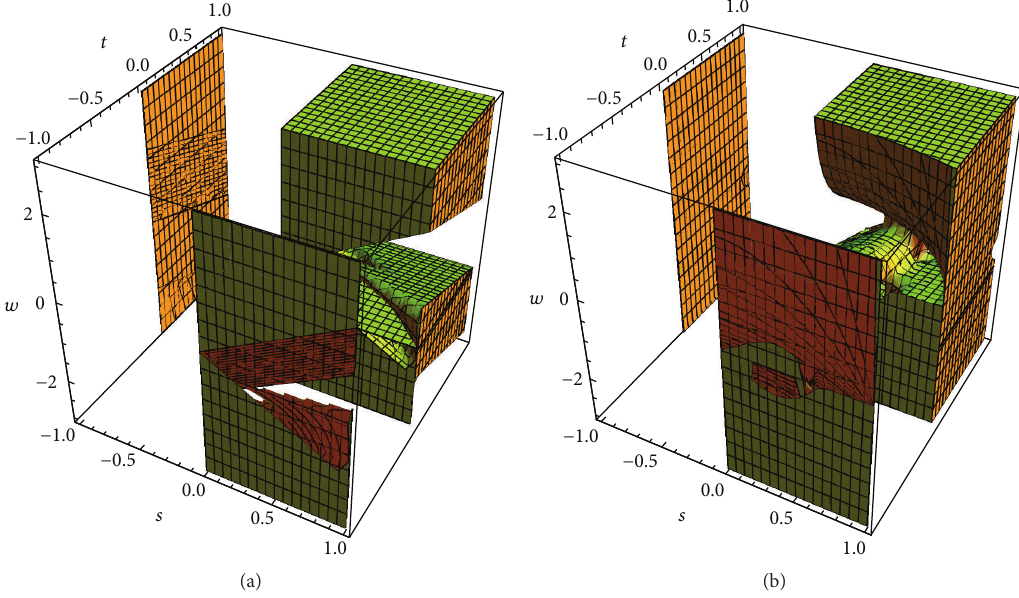
Figure 4: CC region where (a) 𝜇 1 is positive and (b) 𝜇 2 is positive subject to the constraints 𝐶(𝑠,𝑤, 𝑡) and 𝐶 ∗ (𝑠,𝑤, 𝑡) .